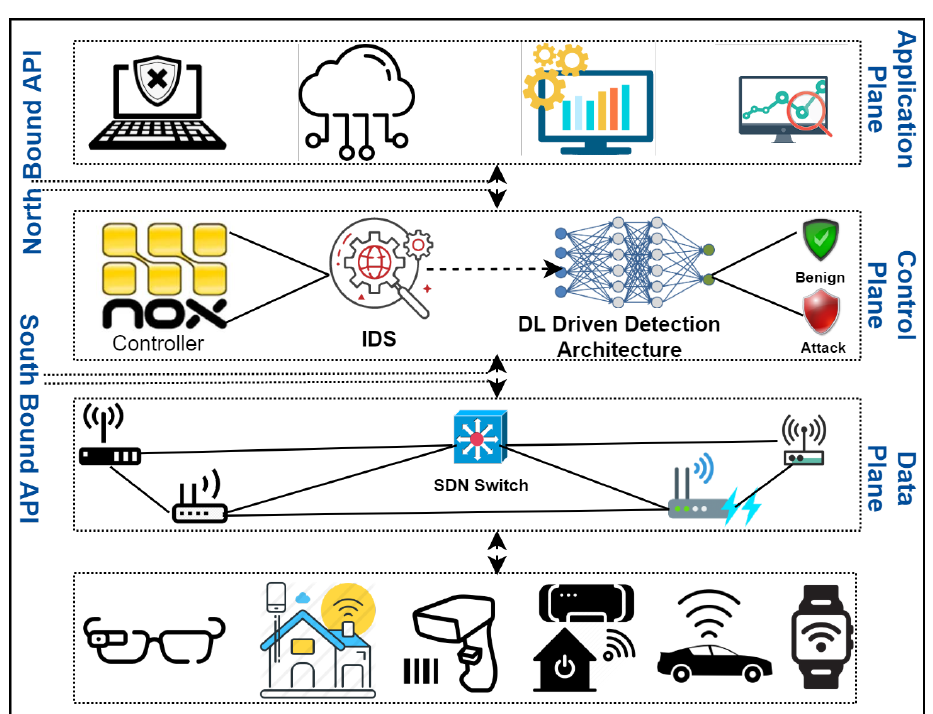
Figure 1. DL-driven software-defined network (SDN)-enabled framework. IDS: intrusion detec- tion